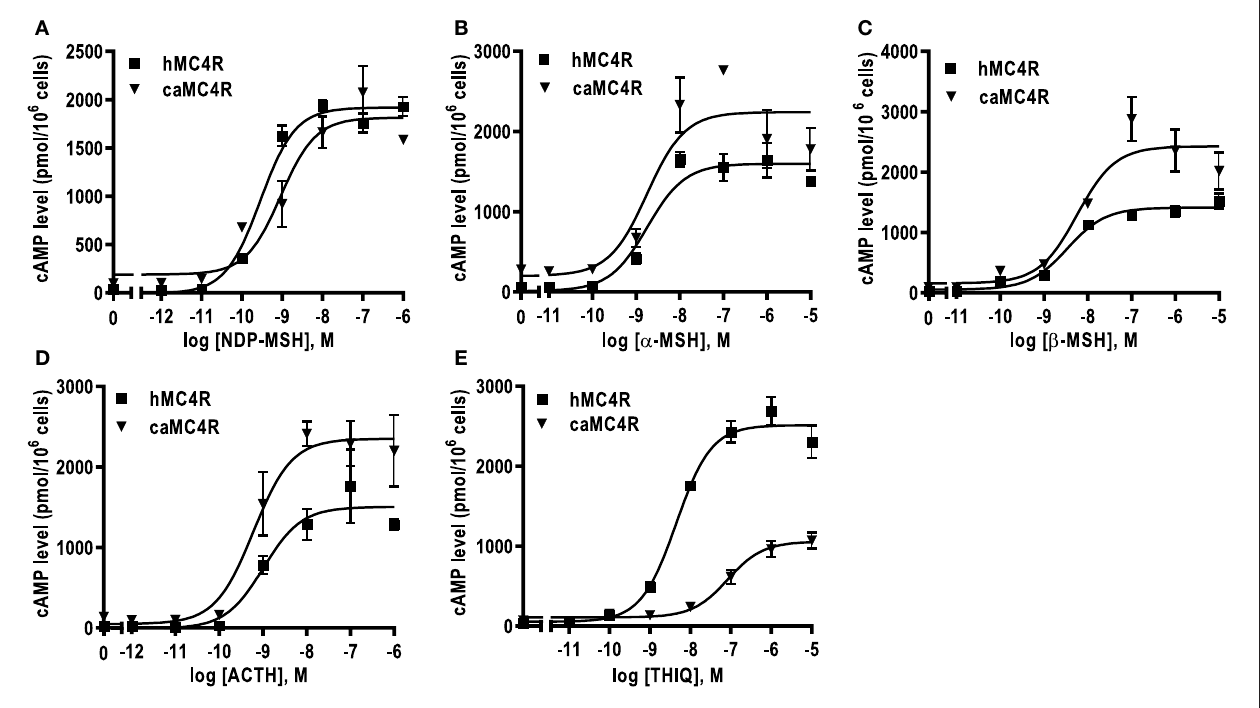
FIGURE 5 | Signaling properties of caMC4R. HEK293T cells were transiently transfected with MC4R plasmids. Forty-eight hours after transfection, cells were stimulated with different concentrations of NDP-MSH (A) , α -MSH (B) , β -MSH (C) , ACTH (1–24) (D) , and THIQ (E) . Data are mean ± SEM from triplicate measurements within one experiment. All experiments were performed at least three times independently.